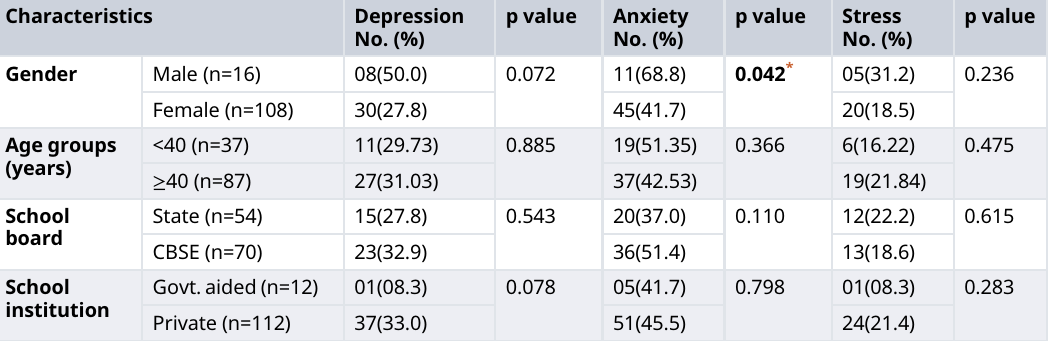
Table 4. Comparison of demographic characteristics with depression, anxiety and stress levels among schoolteachers.